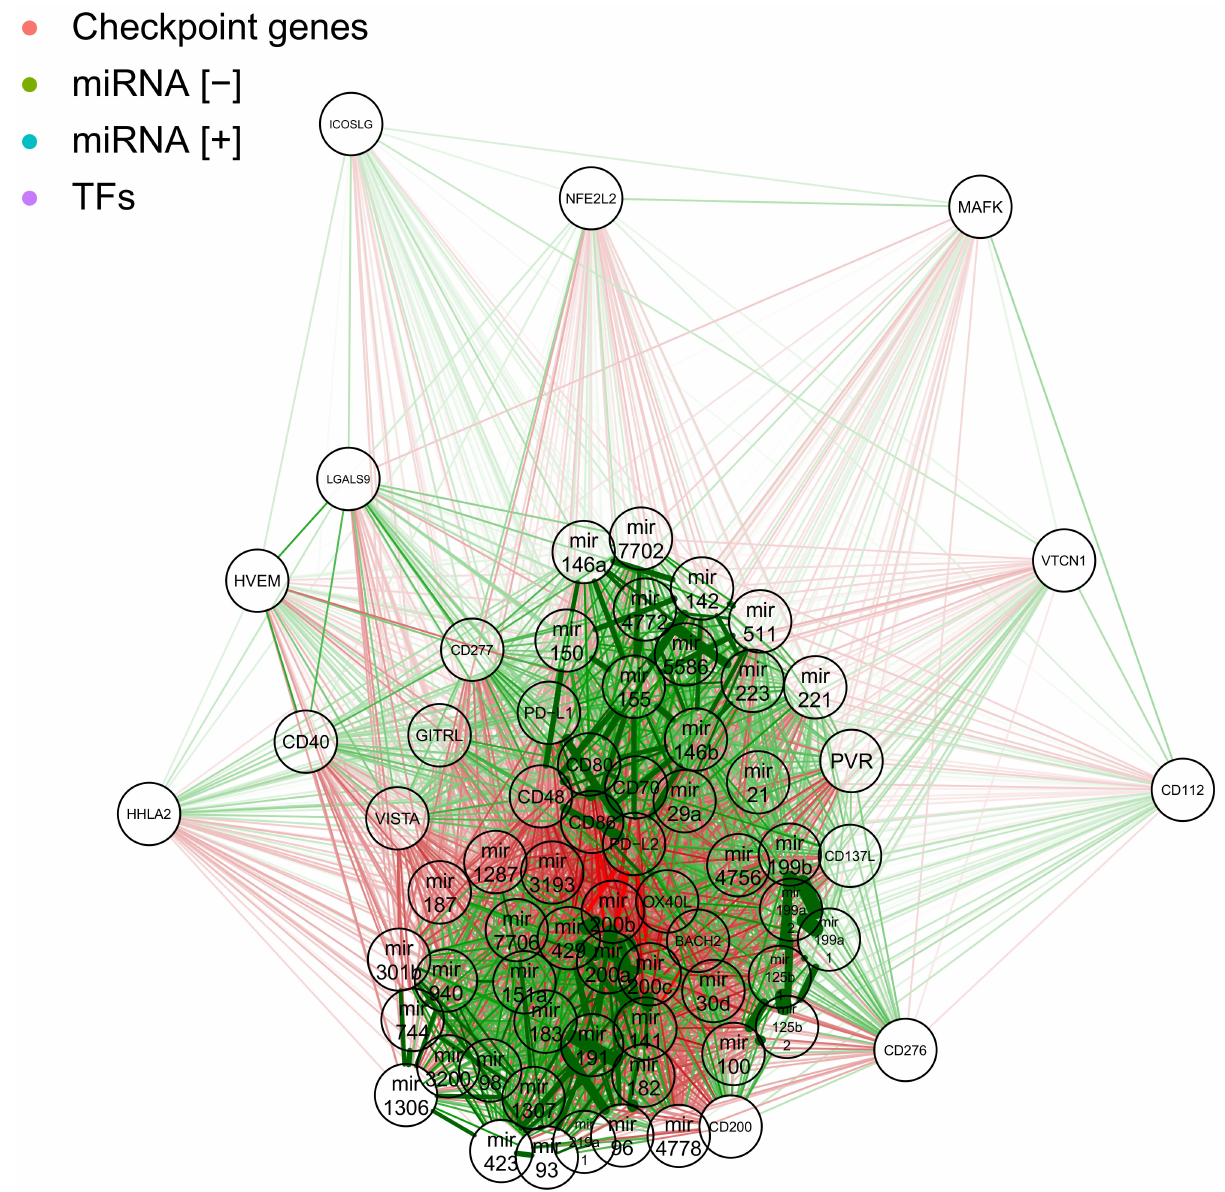
Figure 8. Combined expression correlation network showing negative (green nodes) and positive (blue nodes) miRNAs hits; immunological checkpoint genes (red nodes): CD112, CD137L, CD200, CD276, CD277, CD40, CD48, CD70, CD80, CD86, GITRL, HHLA2, HVEM, ICOSLG, LGALS9, OX40L, PD − L1, PD − L2, PVR, VISTA and VTCN1; and transcription factors (purple nodes): BACH2, MAFK and NFE2L2. Green lines represent positive correlations and red lines represent negative ones. Line thickness represents the strength of the